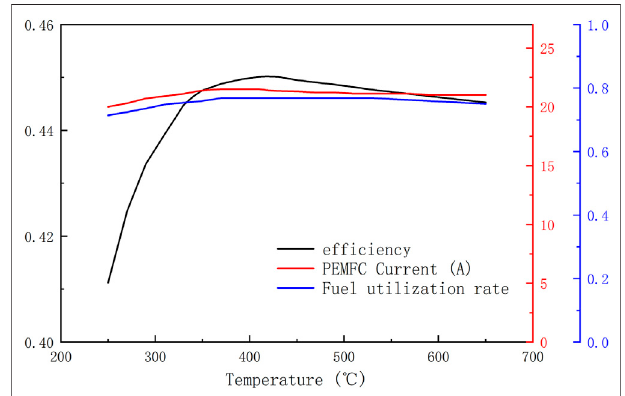
FIGURE 5 | The system ’ s maximum ef fi ciency of different reaction temperatures and the corresponding fuel utilization rate, working current value.